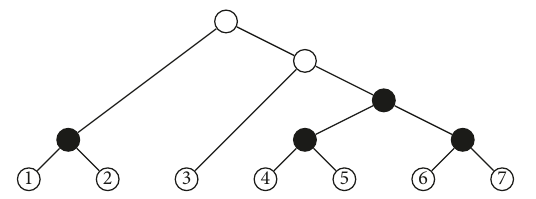
Figure 2: A cladogram in T 7 . The black nodes are its symmetric branch points.